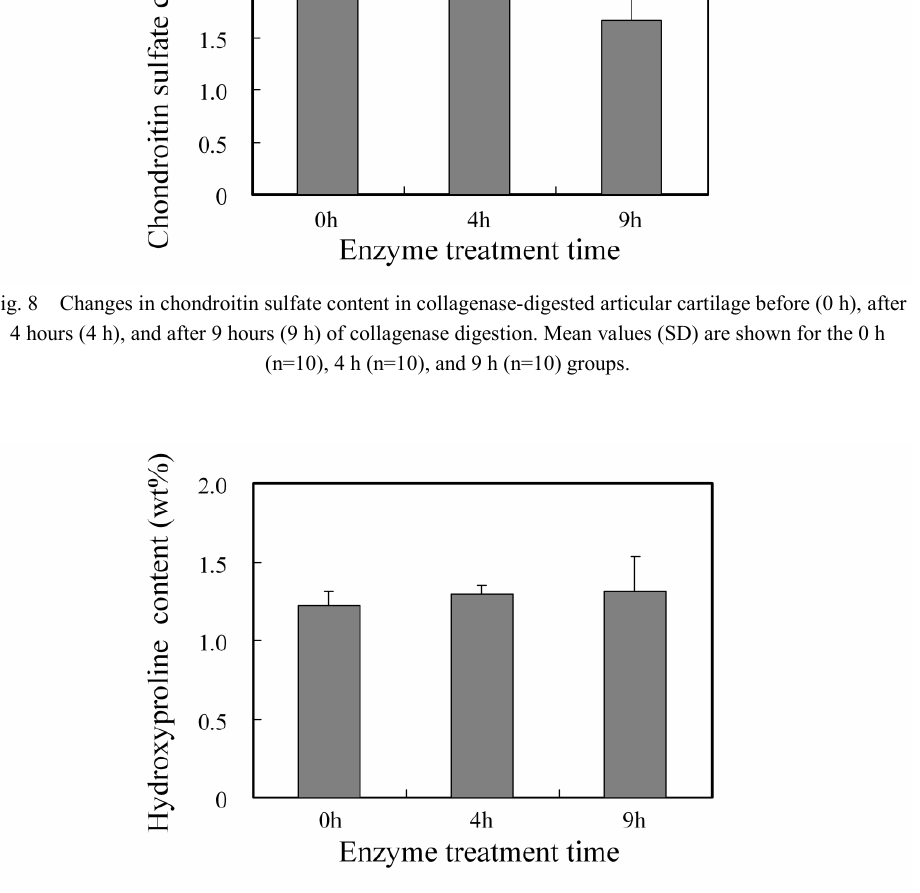
Fig. 9 Changes in hydroxyproline content in collagenase-digested articular cartilage before (0 h), after 4 hours (4 h), and after 9 hours (9 h) of collagenase digestion. Mean values (SD) are shown for the 0 h (n=10), 4 h (n=10), and 9 h (n=10)